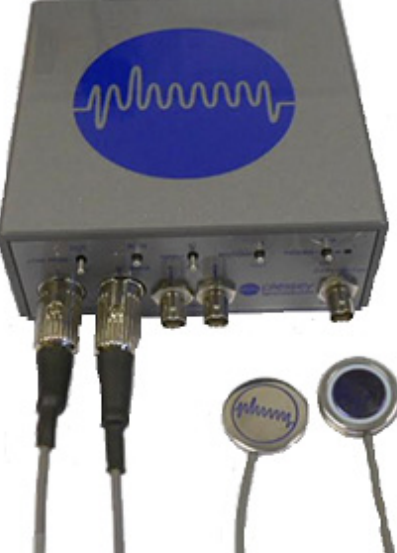
Figure 2. Plessey, EPIC™ evaluation